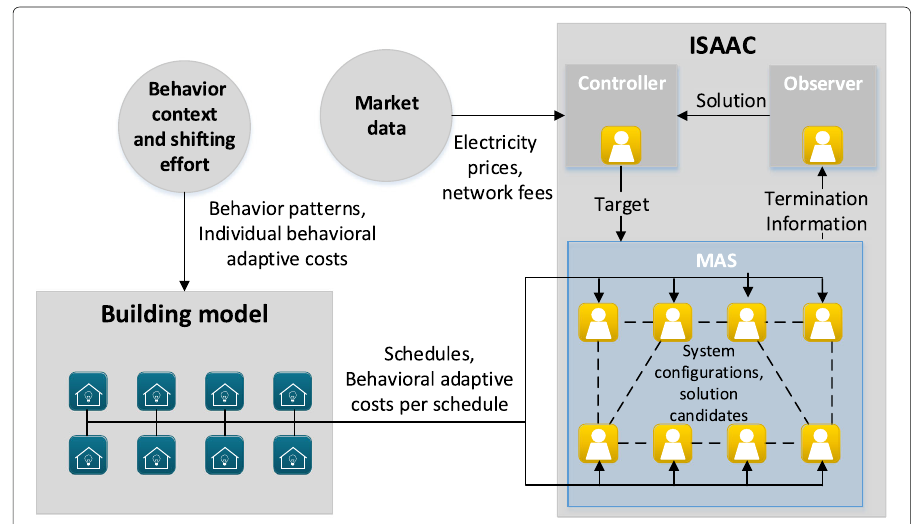
Fig. 1 Data generation and data flow for the simulation of the distributed optimization